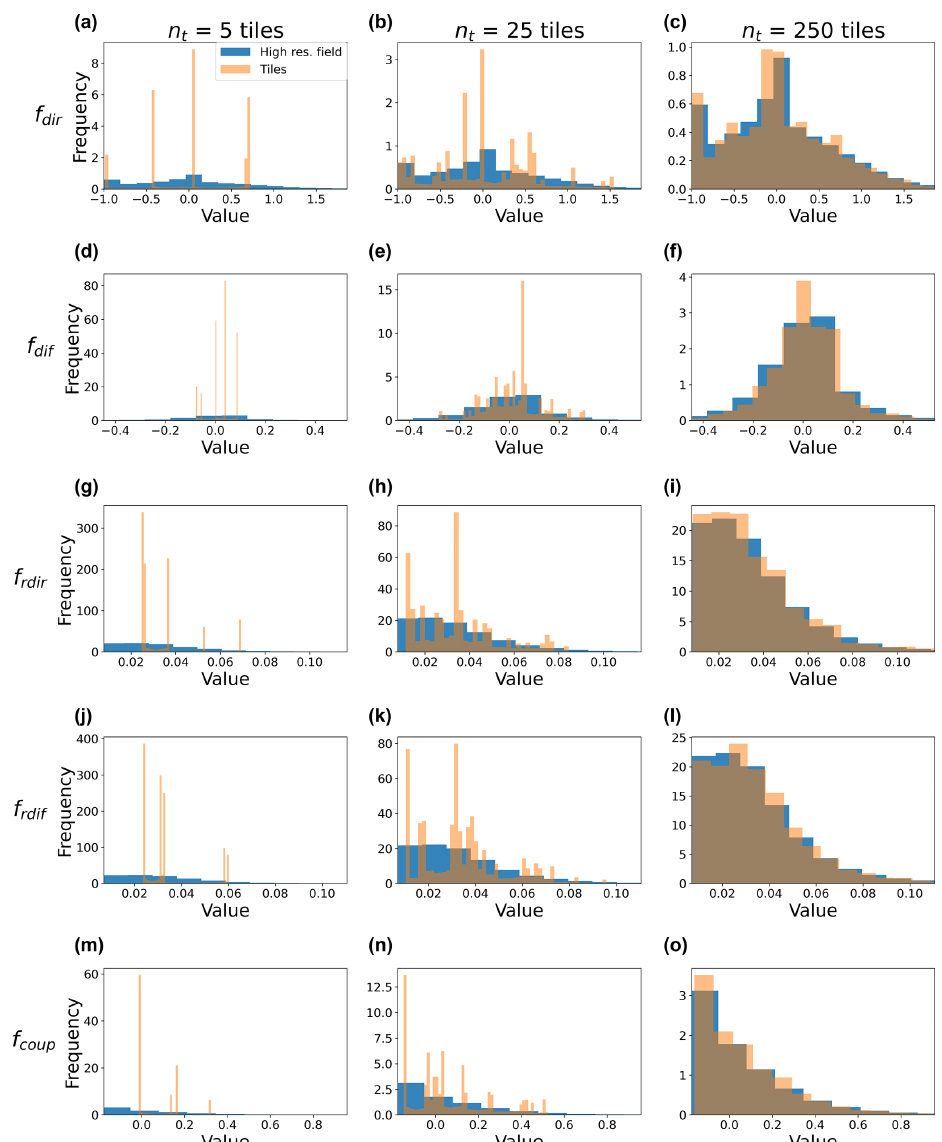
Figure 8. Histograms of the distribution of 3D–PP incident radiation differences for varying number of tiles. Average 3D correction over each tile (orange) compared with the frequency distribution of the high-resolution field (blue histograms). Results are shown for the eastern Alps domain, for a given solar angle ( µ 0 = 0 .